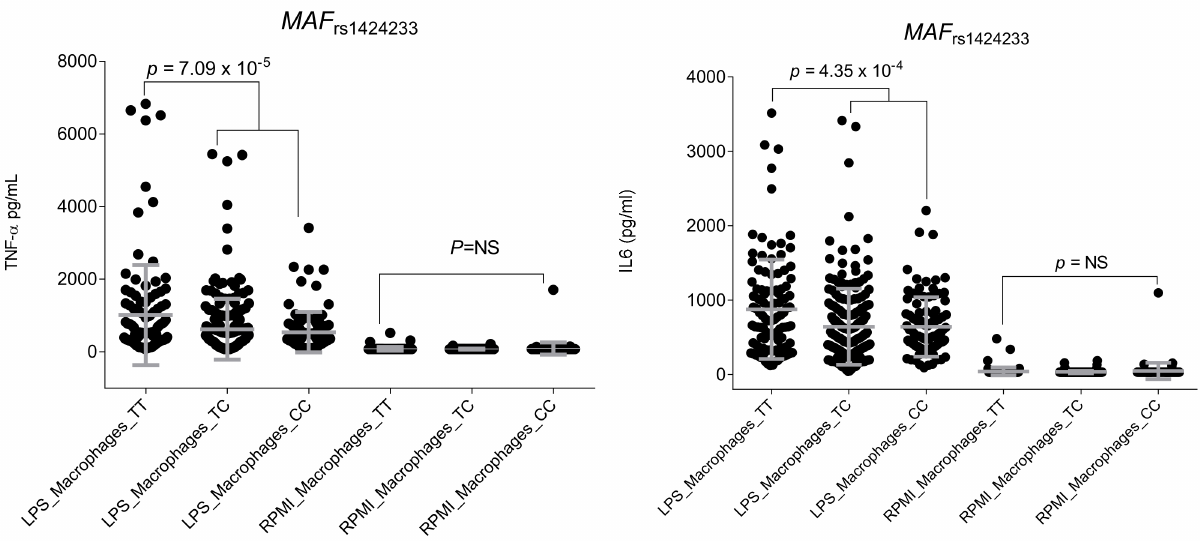
Figure 1. Correlation of the MAF rs1424233 SNP with TNF α and IL6 levels after stimulation of macrophages with LPS ( n =